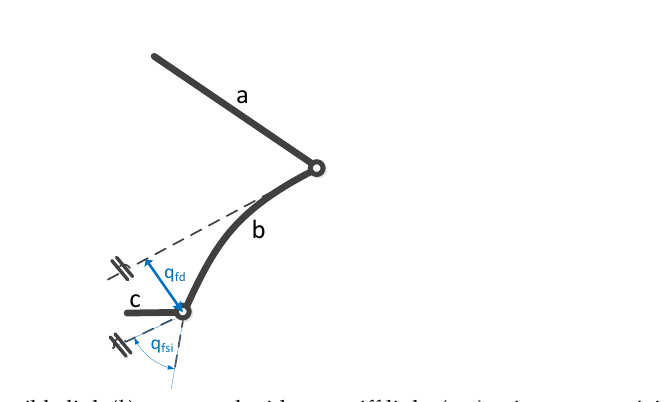
Figure 2. Schematic of a flexible link ( b ) connected with two stiff links ( a , c ) using rotatory